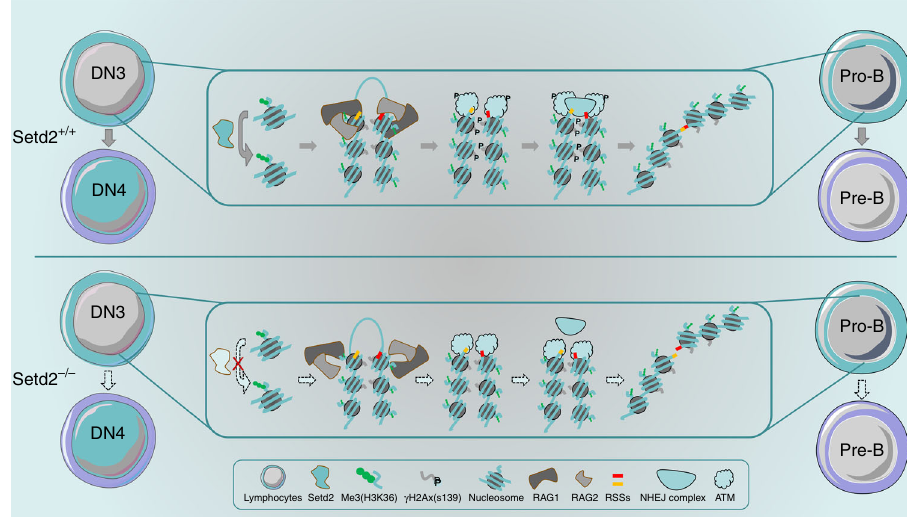
Fig. 7 Working model for the role of Setd2 in V(D)J rearrangement during early T or B cell development. V(D)J rearrangement is a key event in the generation of diverse antigen receptors and in normal lymphoid development and occurs at the DN3 to DN4 stage in T cells and the pro-B to pre-B stage in B cells. Setd2, a major enzyme that catalyzes the trimethylation of the lysine residue at H3K36, is required for the recruitment of the key recombinase RAG1 to the TCR β and Igh gene loci and subsequent ATM-mediated DNA damage repair. Setd2 deletion leads to a loss of H3K36me3 and markedly abrogates V (D)J rearrangement of TCR β and Igh, which causes a severe developmental block at the DN3 and pro-B stages in T and B lymphocytes,